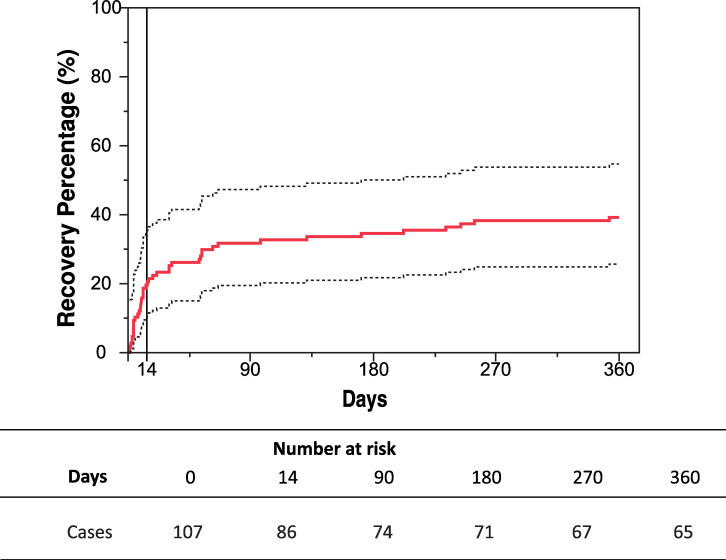
Recovery percentage of CHIKV-infected patients over the time.Recovery percentage was analyzed by Kaplan-Meier survival curve (solid line) and 95% confidence intervals (dashed line). The numbers at risk represent the number of cases with arthralgia at each time point.